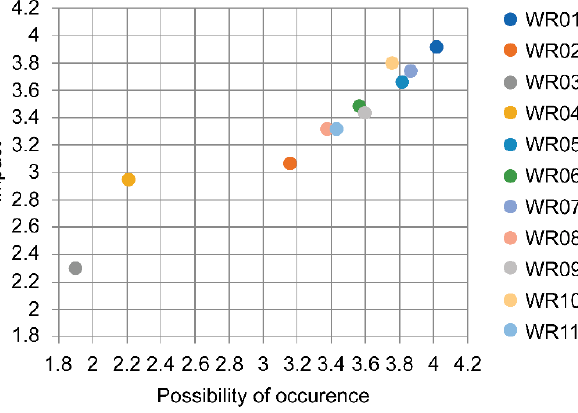
Figure 4. Risk of WR (water resources risk/vulnerability).